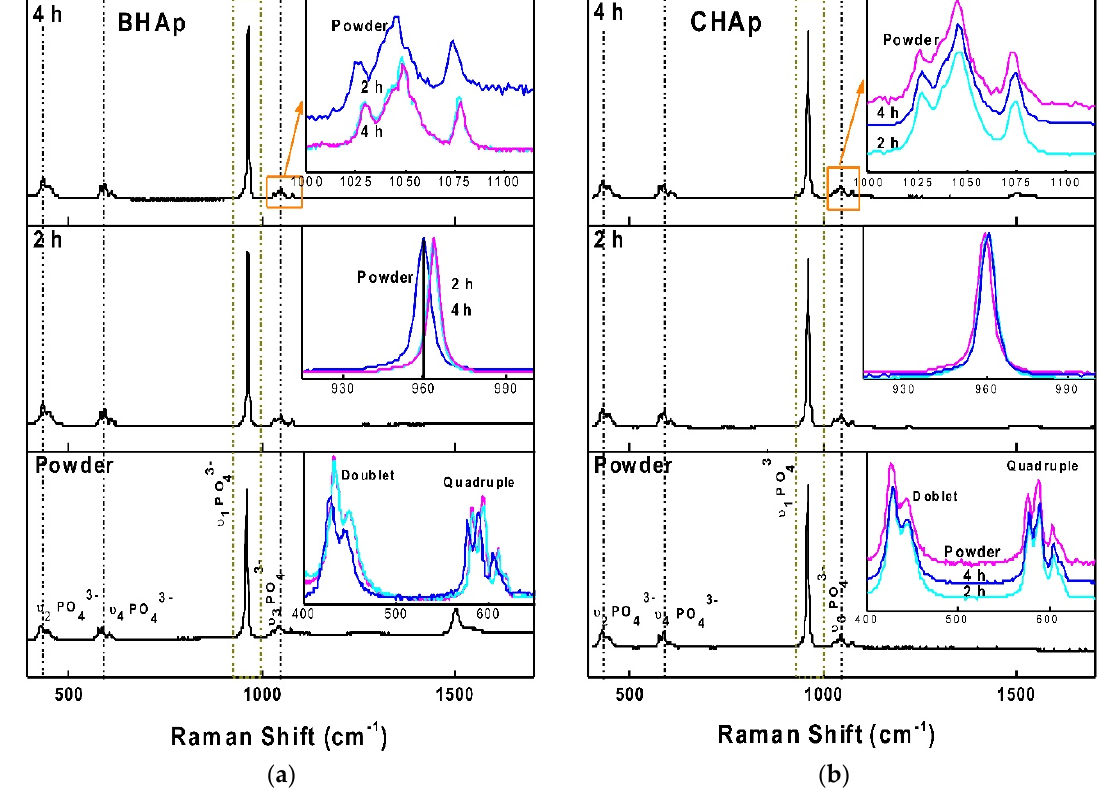
Figure 5. Raman spectra with the main bands for ( a ) BHAp and ( b ) CHAp, showing the position of vibration modes for powders and HAp sintered ceramics at 2 h and 4 h.